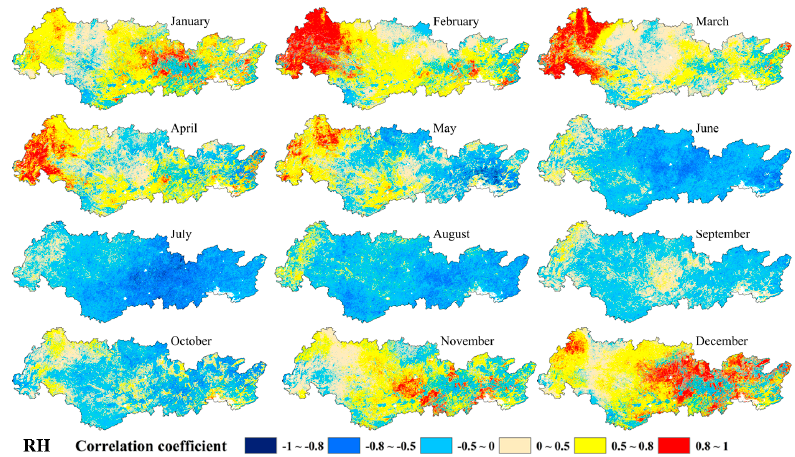
Figure 9. Spatial distribution of the correlation coefficient between ET and relative humidity (RH) in the PRB.